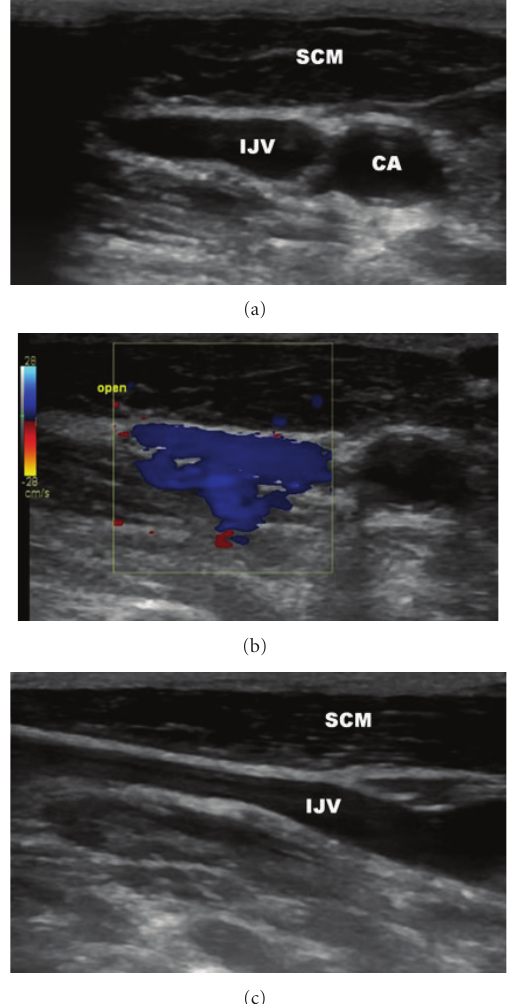
Figure 3: Sonography of left the internal jugular vein before the surgical procedure, mouth opened. (a) transverse imaging, (b) transverse imaging, good flow through the vein as demonstrated by blue color, (c) longitudinal imaging; IJV: internal jugular vein, CA: carotid artery, SCM: sternocleidomastoid muscle.